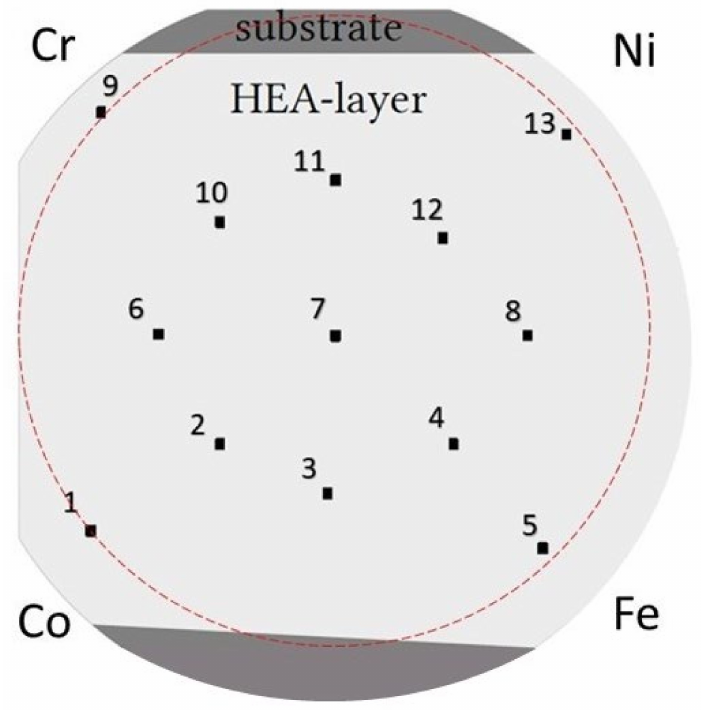
Figure 1. A schematic illustration of the studied locations (numbered from 1 to 13) on the Co-Cr-Fe-Ni thin film. The approximate positions of the four sputtering sources are also indicated. The dark grey areas show the parts of the Si substrate that were not covered by the film due to the masking effect of the sample holder. The dashed circle indicates the area for which concentration maps of the four constituent elements were